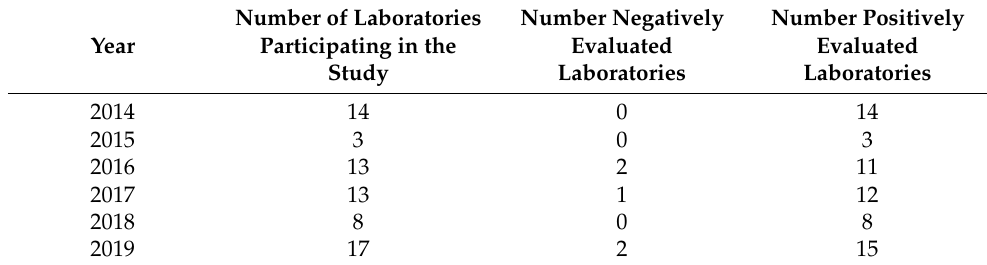
Table 6. Laboratory quantitative